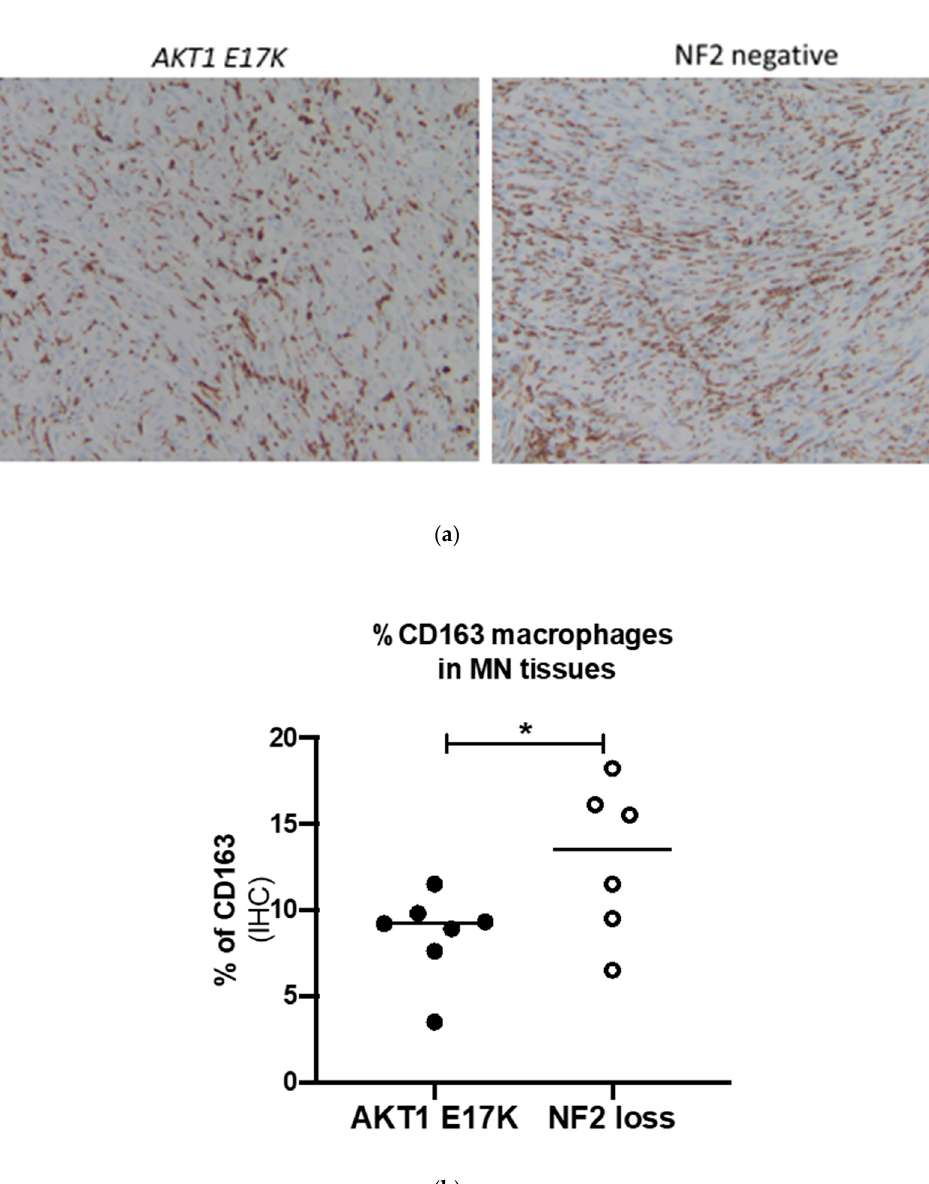
Figure 3. (a) Representative immunohistochemistry images for CD68-stained macrophages in AKT1 E17K- and NF2-negative meningiomas, ×100 magnification (b) % of CD68+ cells in AKT1 E17K mutants ( n = 7) compared to WHO grade I NF2-negative ( n = 6) meningiomas by IHC; line represents the median, * p < 0.05.